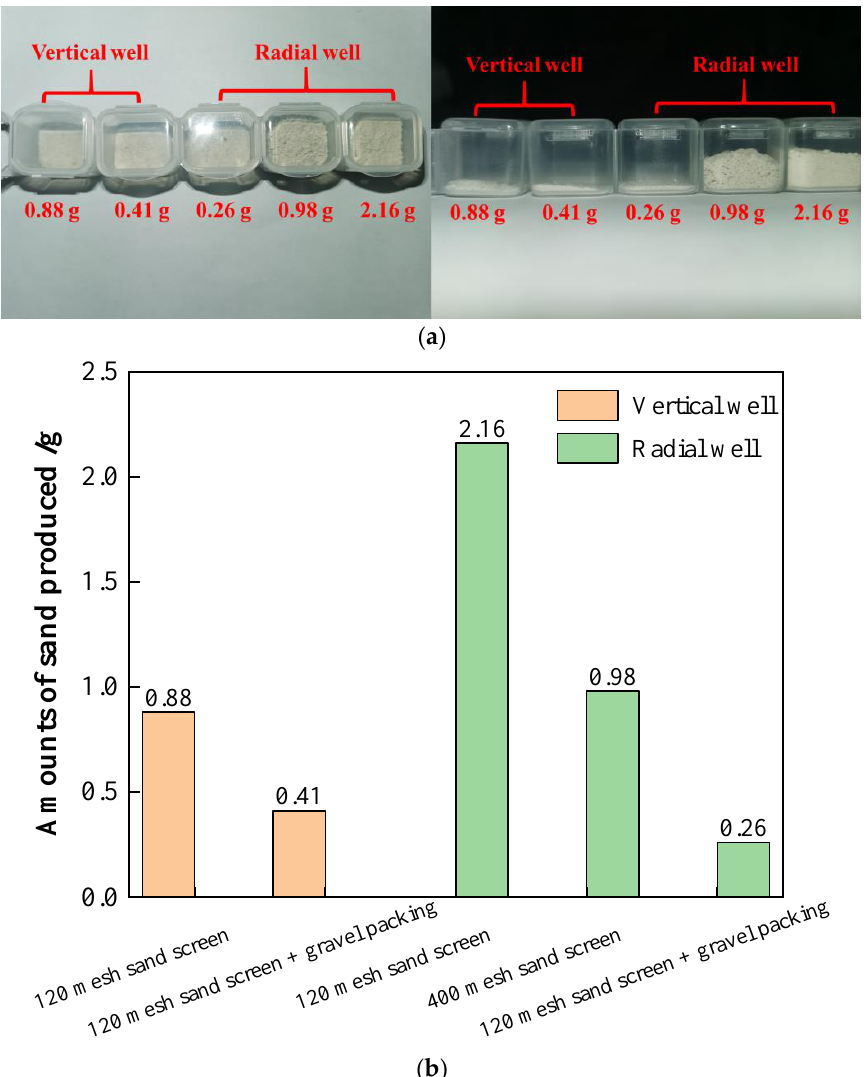
Figure 12. ( a ) Real shots of sand production in vertical and radial wells; ( b ) Schematic diagram of sand production in vertical and radial wells.